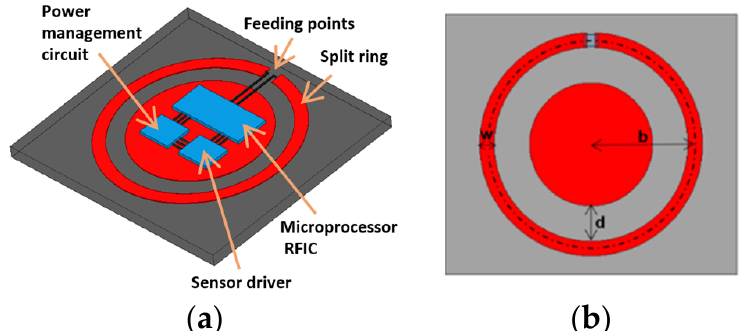
Figure 1. ( a ) The device architecture of the resonate coupler. The center pad reserves a space to in- tegrate circuitry. ( b )The coupler dimensions: the radius b ; the loop width w = 2a ; and the tuning gap d between the pad and ring.